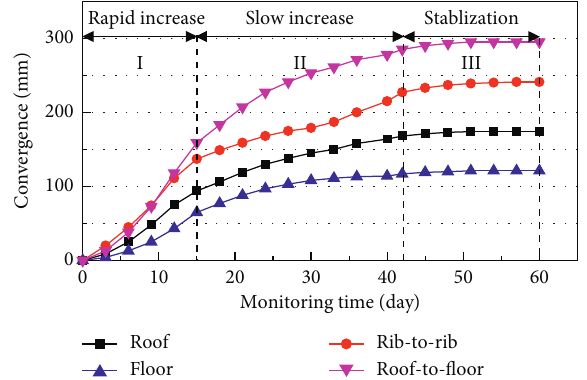
Figure 17: Monitored convergences in the 1128 open-off